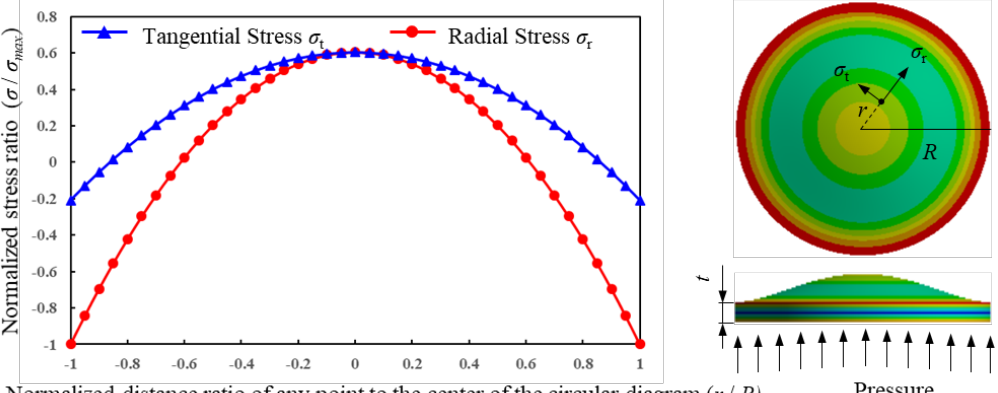
Figure 1. Common structures of pressure sensor’s sensitive diaphragm.